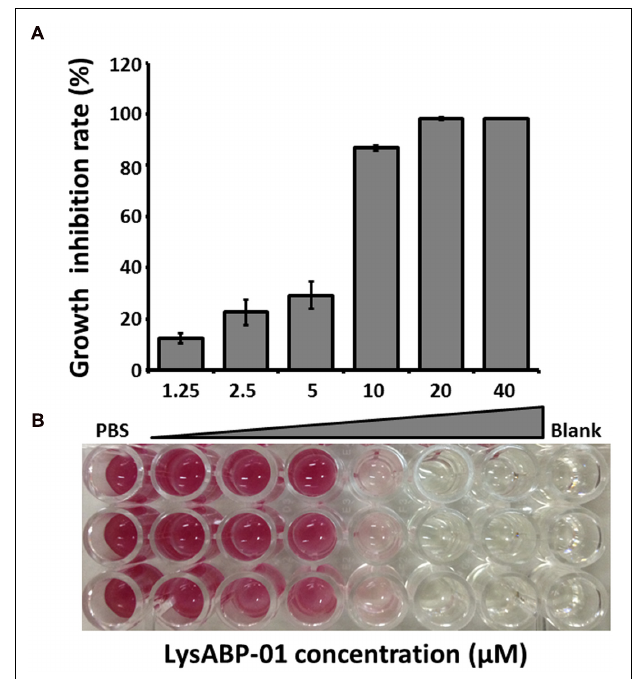
FIGURE 3 | Antibacterial activity of LysABP-01. (A) Bacterial growth inhibition activity of varying concentrations of LysABP-01. The bar graph depicts the percent growth inhibition and represents the mean percentage ± SD of triplicate experiments. (B) The representative microplate image of TTC